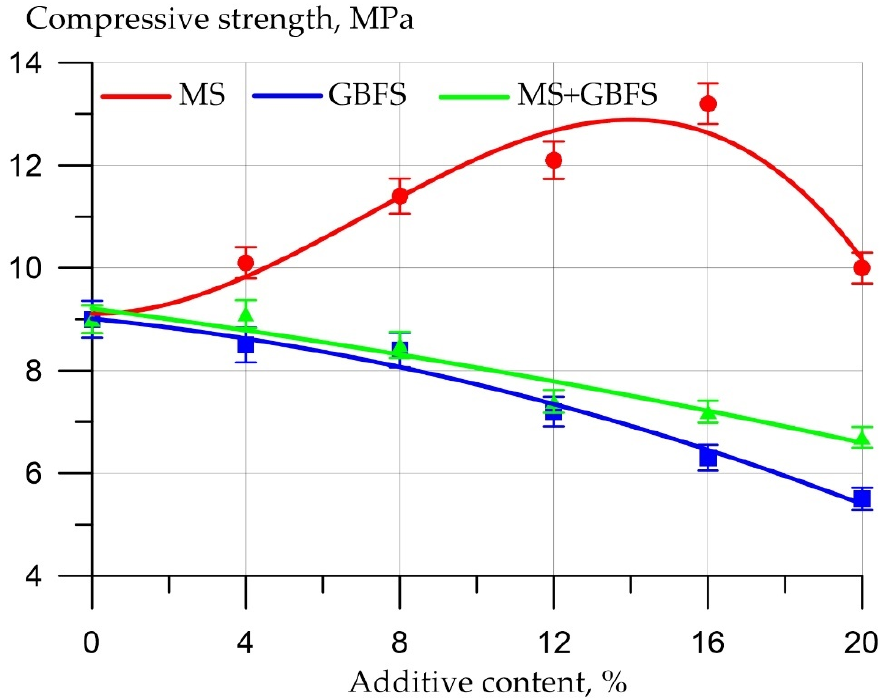
Figure 6. Change in compressive strength of non-autoclaved aerated concrete samples depending on the percentage of binder replacement by various types of additives.